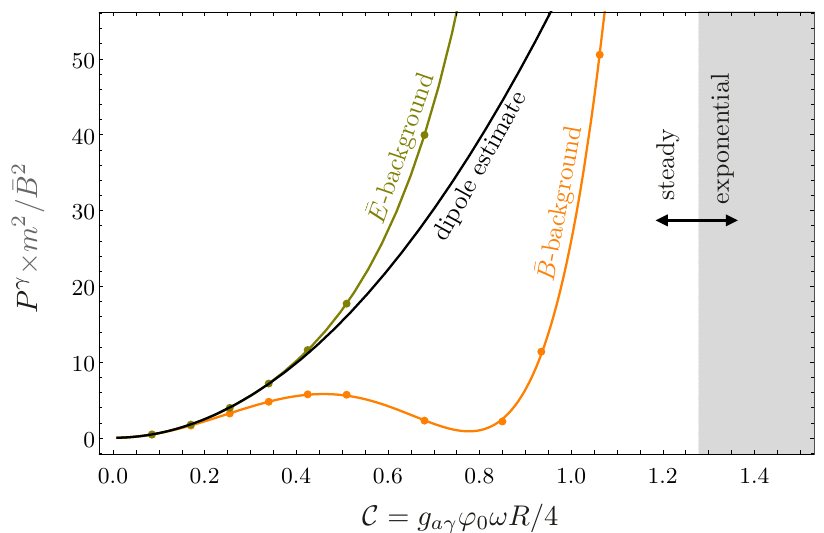
Figure 7 . The dependence of the time-averaged radiated power h P γ i t on the effective dimensionless coupling C = g 4 . The above plot is based on a dense soliton of field amplitude ϕ = 2 . 6 f , aγ ϕ 0 ωR/ 0 frequency ω = 0 . 82 m and radius R = 1 . 6 m − 1 . For changing C ≈ 0 . 85( fg ) , only fg is varied. aγ aγ The black line is the dipole estimate h P γ i t from eq. (4.14). The orange and green dots show the (2) numerically evaluated h P γ i for E and B field backgrounds respectively. Note that the numerics t agree with the dipole estimate at C (cid:28) 1 as expected. The deviation becomes more and more pronounced as we move from C (cid:28) 1 towards C ∼ 1 . In particular, note the difference in the radiated power between E and B field backgrounds. For the B background, note the significant suppression of the radiated power compared to the dipole estimate and the non-monotonic behaviour with C . Finally, as C > C = 1 . 3 (grey shaded), we have an exponentially growing (in time) power due to crit parametric